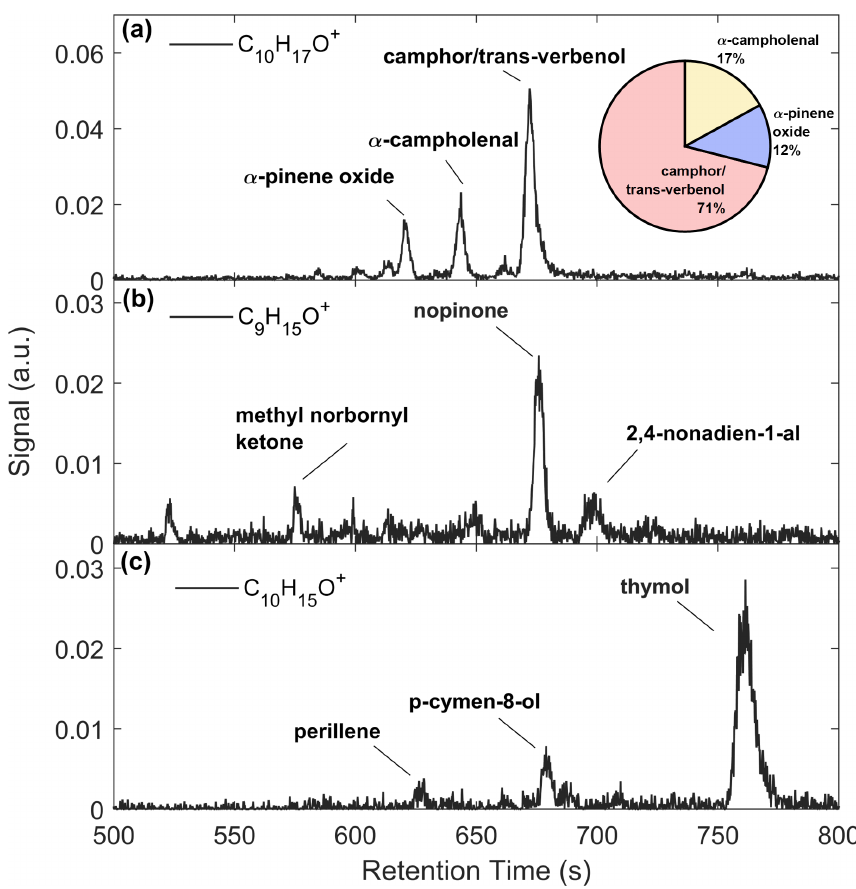
Figure 7. Representative chromatograms of (a) C 10 H 17 O + , (b) C 9 H 15 O + , and (c) C 10 H 15 O +